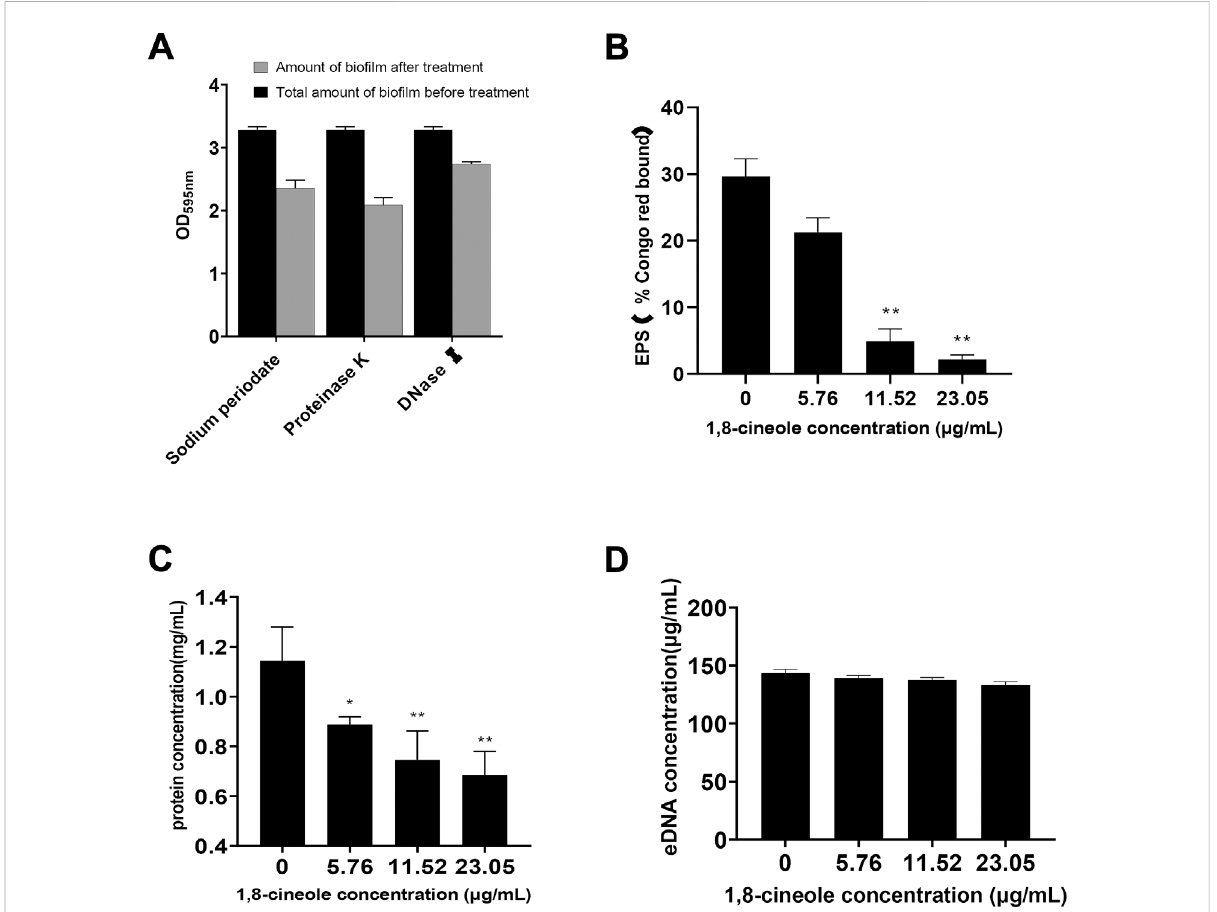
FIGURE 4 Effect of different concentrations of 1,8-cineole on Extracellular matrix. (A) The major components of F. solani species complex extracellular matrix were analyzed byadding to thepreformed bio fi lm protease Kto degrade proteins, DNase Ito degrade DNAand sodium periodate to degrade β -1,6-linked polysaccharides. Bio fi lms were developed in 24-well plates incubated at 27 C for 72 h in RPMI 1640 medium and quanti fi ed by crystal violet assay. (B) The effect of1,8-cineole on theextracellular polysaccharide (EPS) wasevaluated using Congo red test. (C) Effect of 1,8-cineole on extracellular proteins was determined by Coomassie Brilliant Blue staining method. (D) The impact of various concentrations of 1,8-cineole on eDNA was evaluated by using Phenol chloroform method. Comparisons between absorbance levels revealed signi fi cant differences. *, p < 0.05; **, p <